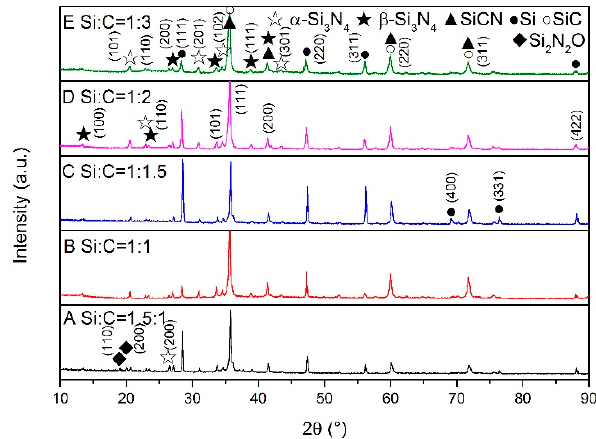
Figure 2. XRD patterns of samples with different Si/C ratios synthesized at 1450 °C.